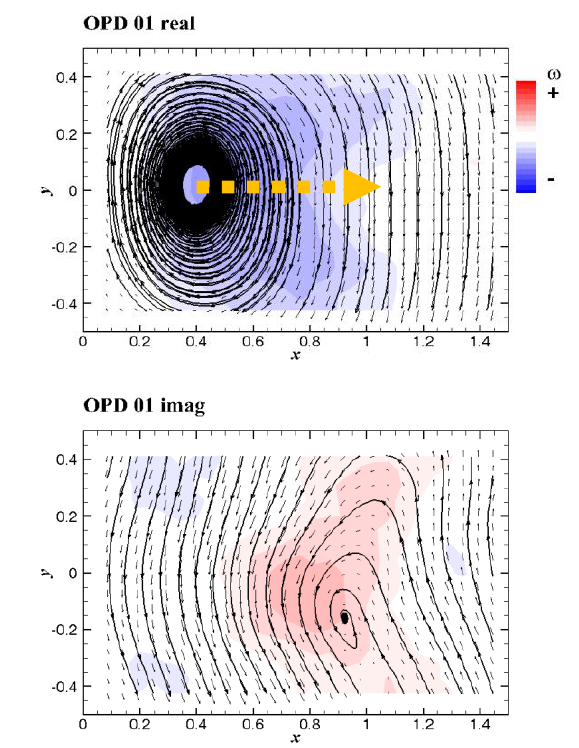
Fig. 10. Topology of the 1 st OPD mode, real and imaginary parts